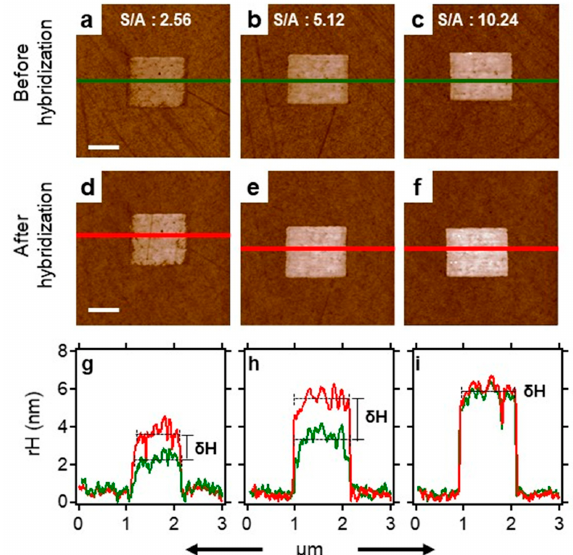
Figure 6. Height profile measurement of a density-dependent ssDNA nanopatch before and after treatment with 500 nM Scheme 381. conjugate. ( a – c ) show the AFM micrographs of a thiol-modified ssDNA nanopatch at different ssDNA densities as defined by density factor (S/A, as defined in Section 2.6). ( d – f ) display the AFM micrographs of the dsDNA–pep381 nanopatch obtained after treating ( a – c ) with the 500 nM solution of complementary ssDNA–pep381 conjugate. ( g – i ) show the height profiles across ( a – c ) and ( d – f ) in green and red, respectively. δ H is the change in relative height corresponding to the difference between the average relative heights. These averages are highlighted as black dashed lines across the profiles. The scale bar is 600 nm for all the micrographs.